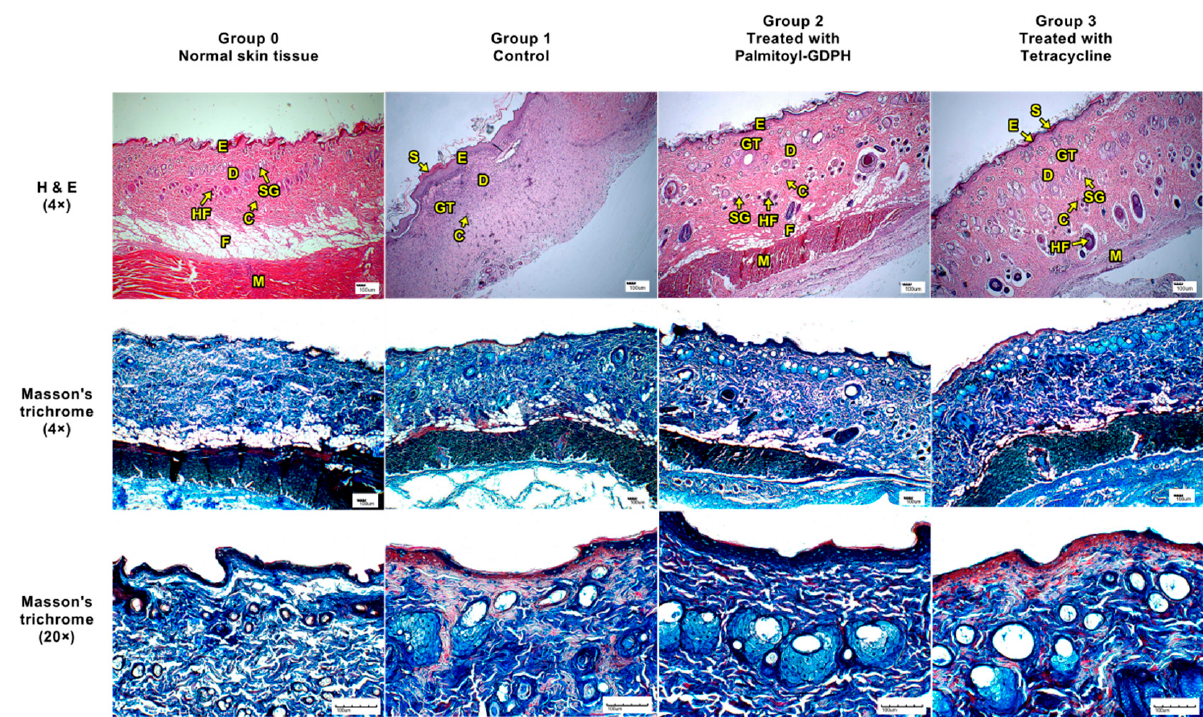
Figure 5. Histological section (H & E) and Masson’s trichrome staining of the healed wound on day 18 post-surgery. The arrow showed epithelialization. S-Scar; E-Epidermis; D-Dermis; GT-Granulation tissue; C-Capillaries; HF-Hair follicle; F-Fat; M-Muscle; SG-Sweat gland. Magnification at 4× (H & E) and 4×, 20× (Masson’s trichrome).